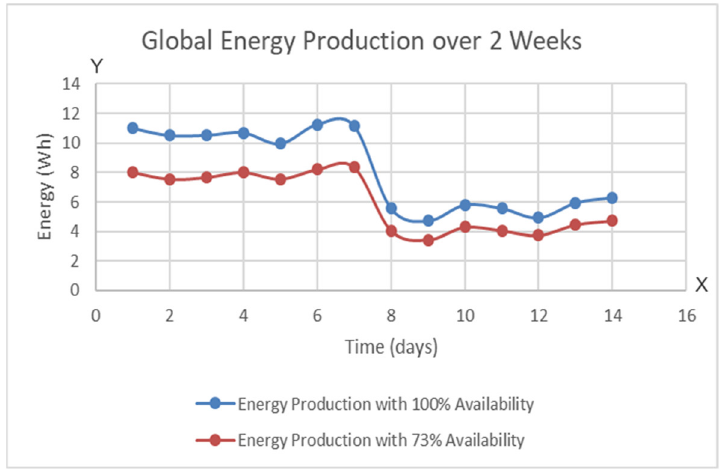
Figure 8. Global Energy Production of the Solar Tracking Device with and without Reliability- Oriented Metrics over Two Weeks. Oriented Metrics over Two